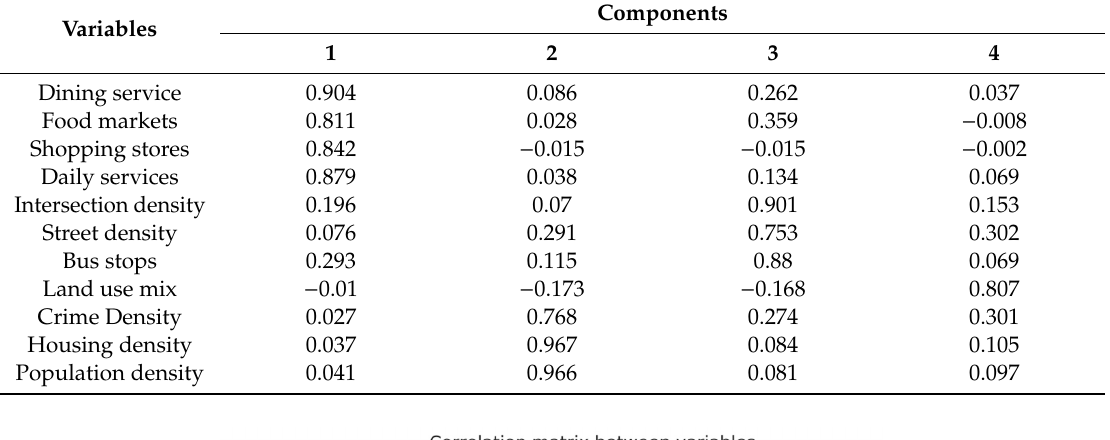
Table 5. Rotated loading matrix